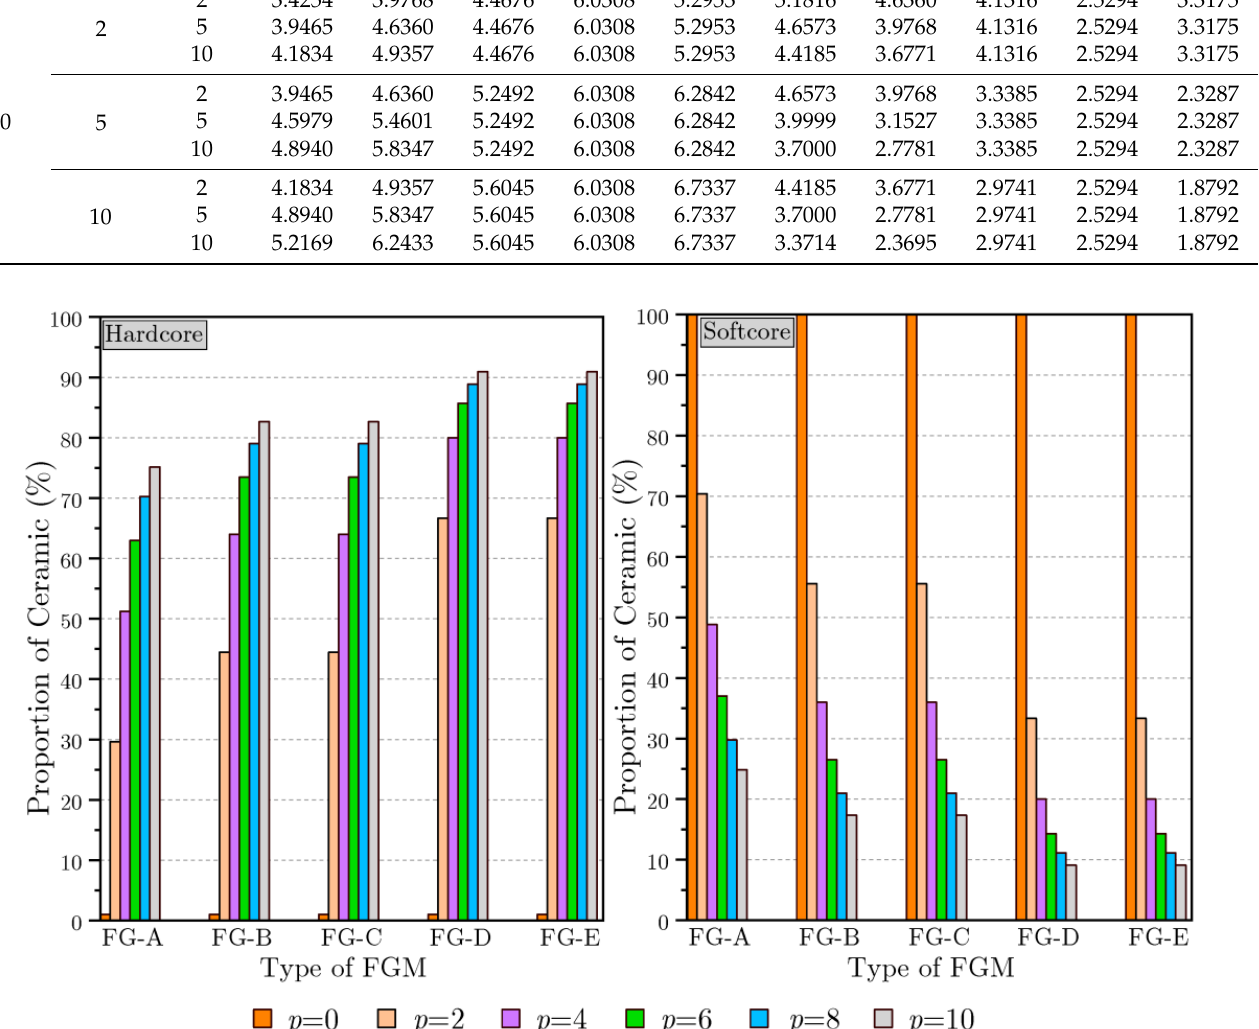
Figure 4. The proportion of ceramic (%) in various types of FG structures (𝑝 = 𝑘 = 𝑒) . Figure 5 plots the variation in the critical buckling load N of various configurations of coated FG shells influenced by the various inhomogeneity material exponents p , k , and e ( p = k = e ). The case of p = k = e = 0 for the hard core shells meant that the shells were fully metal, while for the soft core shells, they were fully ceramic. For the hard core coated FG shells, it was seen that the buckling loads increased due to the increase in